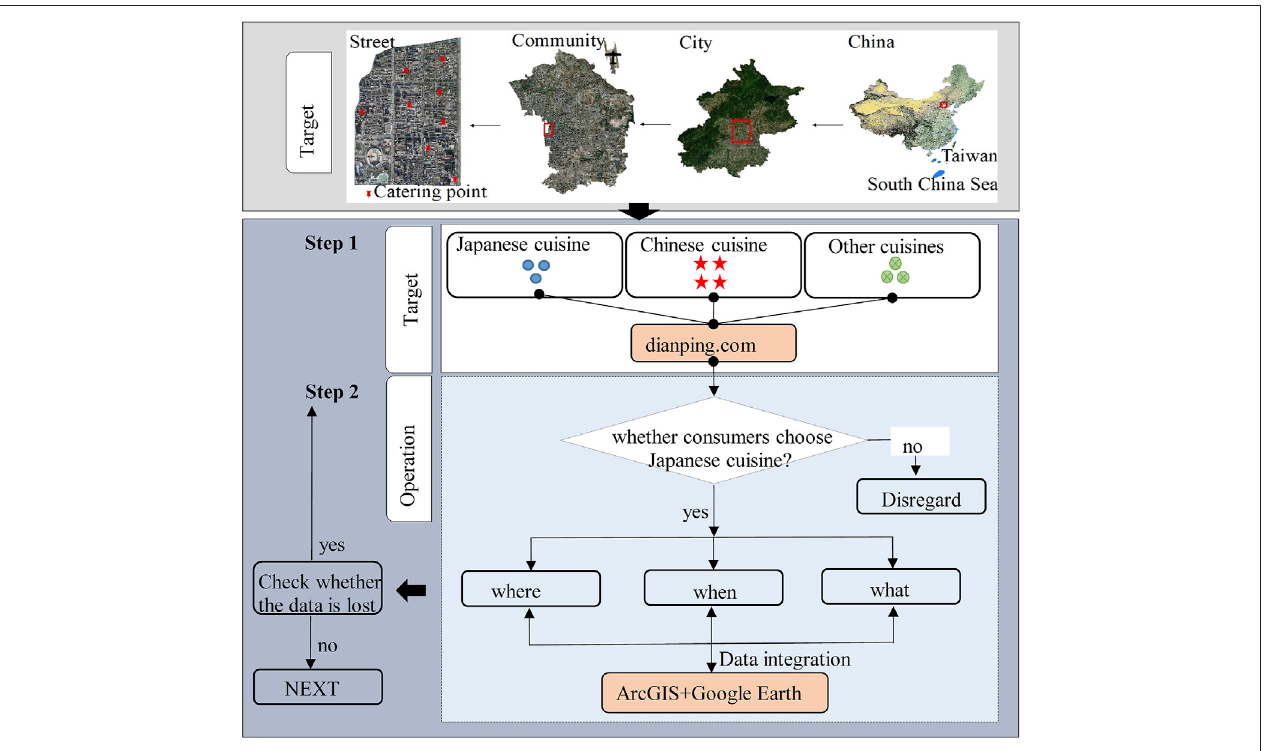
FIGURE 1 | Data acquisition and processing